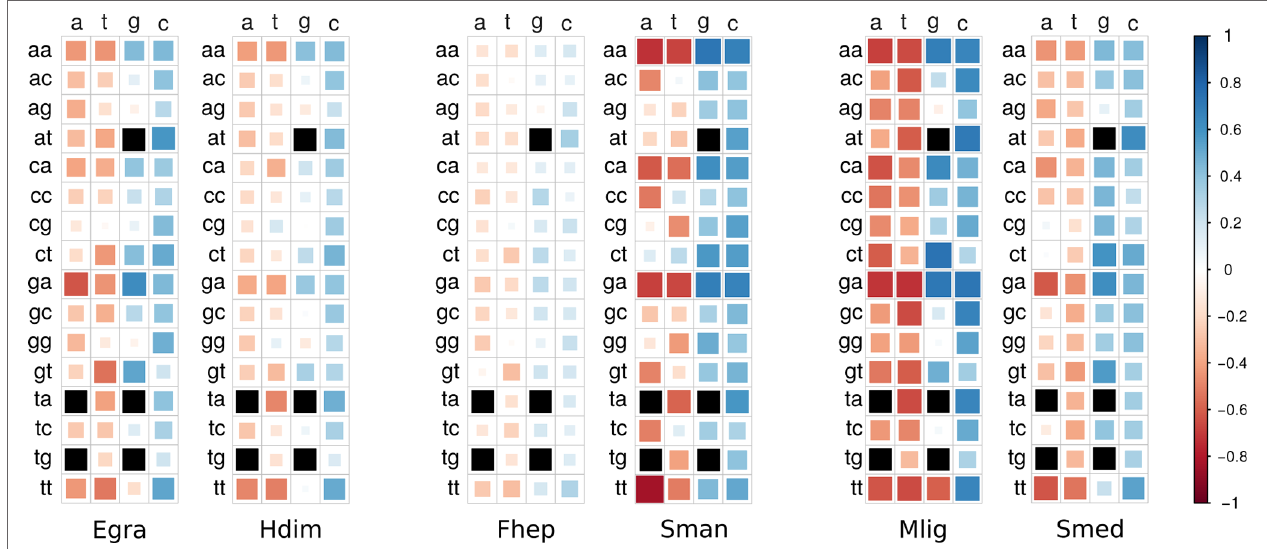
FIGURE 3 | Heatmaps of correlations between codon usage and GC3. Correlation values are coded according to the color scale depicted in the side bar (blue = positive, red = negative). Color intensity and the size of the rectangle are proportional to the correlation coefficients. Black squares: ATG (Met), TGG (Trp), and STOP codons. Organism name abbreviations are as in Table 1